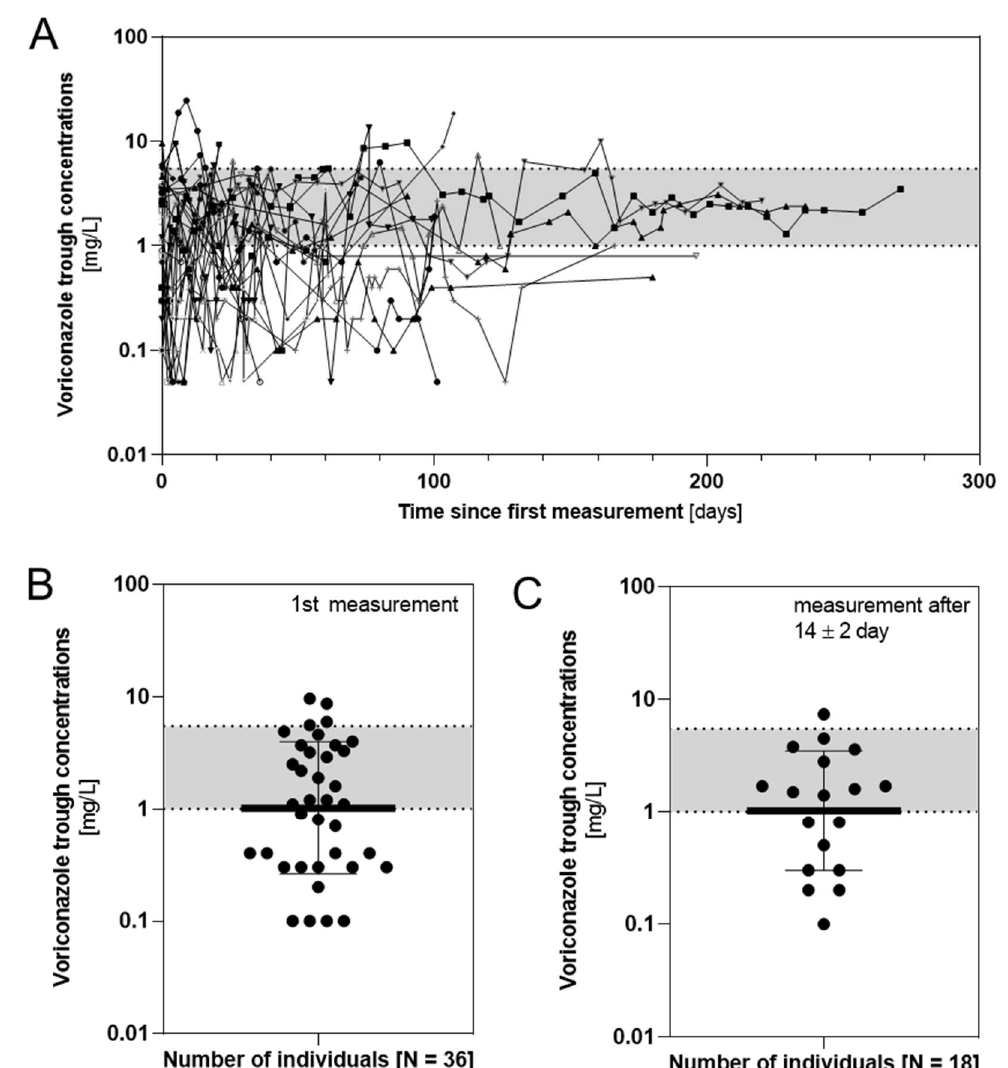
Figure 2. ( A ) C trough from therapeutic drug monitoring over time of all 36 individuals. ( B ) First measurement and ( C ) one measurement per patient after 14 ± 2 days of voriconazole C trough ( n = 383; 8 C trough were excluded, because they were not measured within the same therapeutic intervention period). On the logarithmic scale of the y-axis, the therapeutic window of C trough between 1 and 5.5 mg/L is highlighted in grey.